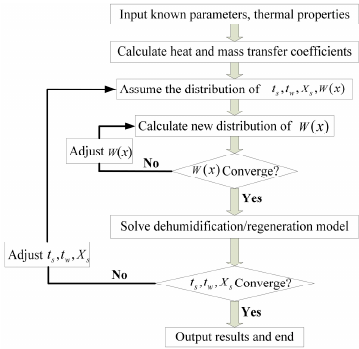
Figure 2. Calculation flow chart for solving the